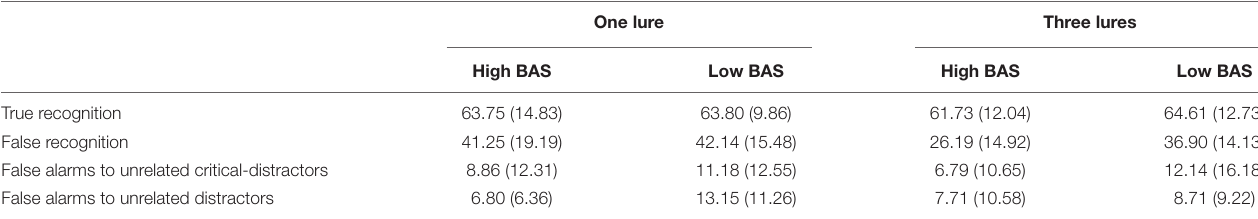
TABLE 2 | Mean Percentage (SD) of True and False Recognition and False Alarms to Unrelated Critical-Distractors and Unrelated Distractors as a function of Number of Critical Lures per List at Test (one vs. three) and BAS (high vs.